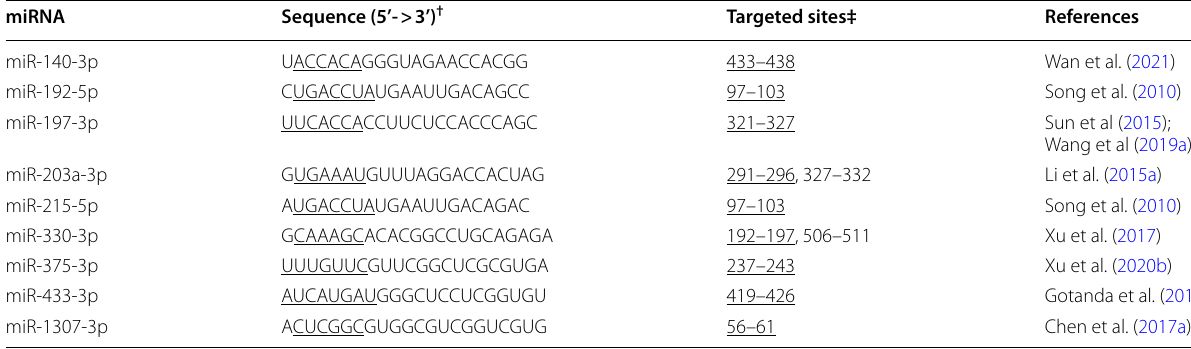
† human miRNA (hsa-miR) sequences were taken from miRBase (www. mirba se. org); seed sequences complementary to the 3’UTR of TYMS mRNA are underlined ‡ 3’UTR TYMS mRNA sites targeted by miRNA seed sequences; the numbers refer to the position after the STOP codon according to the GenBank sequence accession number NM_001071.4; the sites confirmed by the luciferase reporter assay in the cited publication are underlined